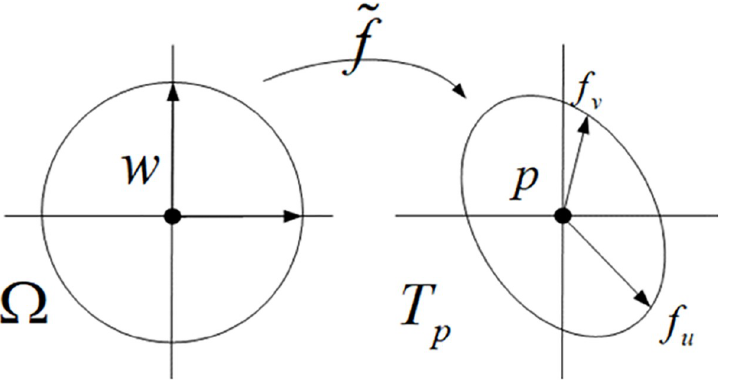
Fig 1. First order Taylor expansion ~ f of the parameterization f